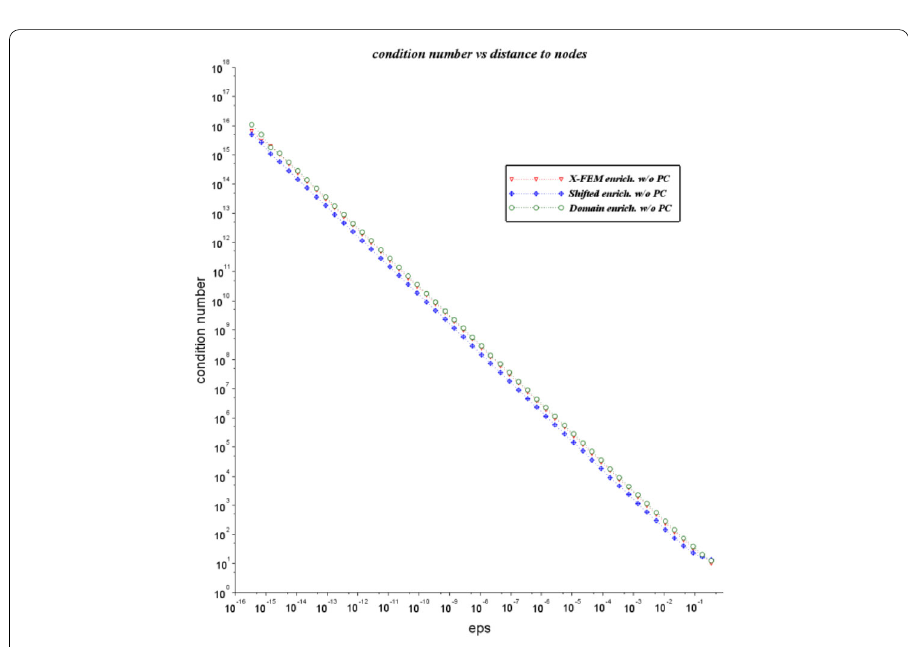
Fig. 10 Conditioning of strongly discontinuous approximations without the use of pre-conditioners. The three approximation spaces yield the same condition number (as they are